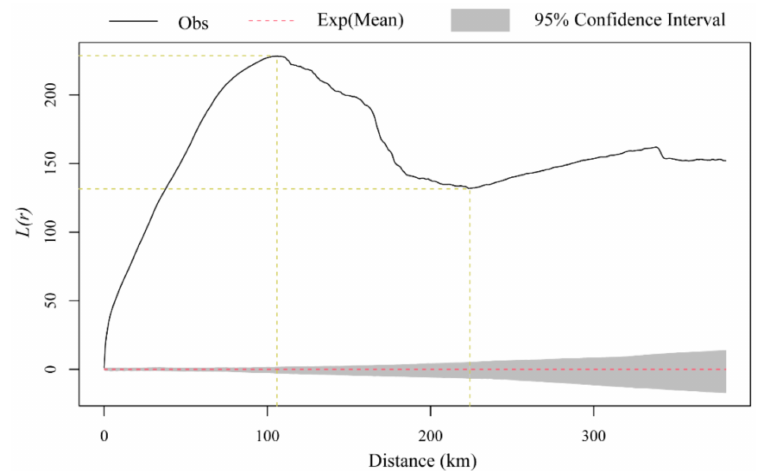
Figure 2. Ripley’s L ( r ) function of picking orchards in